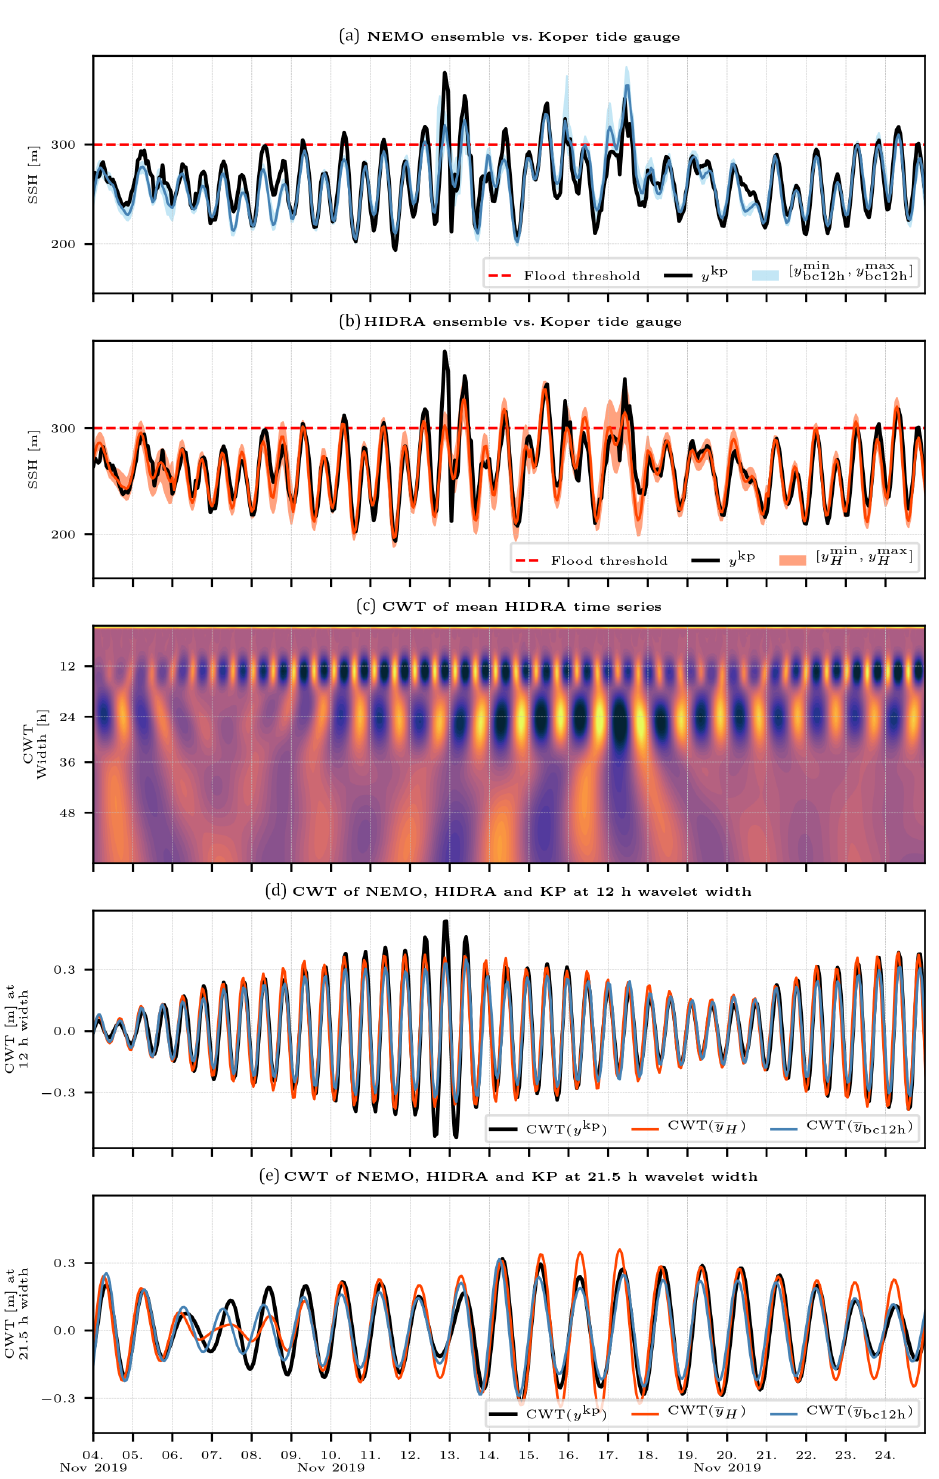
Figure 11. Comparison between NEMO (with a 12h bias correction) and HIDRA ensembles during a historic surge of November 2019. Panels (a) and (b) depict NEMO and HIDRA ensemble predictions for Koper sea level, together with Koper tide gauge time series. Mean values and minimum–maximum ensemble spans are depicted, as defined in Sect. 3.3. Panel (c) depicts a CWT of y H (t) HIDRA mean time series. Panels (d) and (e) depict CWTs of Koper tide gauge, HIDRA and NEMO time series at semi-diurnal (12h) and E 0 (21.5h) wavelet width respectively. The flooding threshold in the historic coastal town of Piran (Slovenia) is marked by a dashed red line in the top two